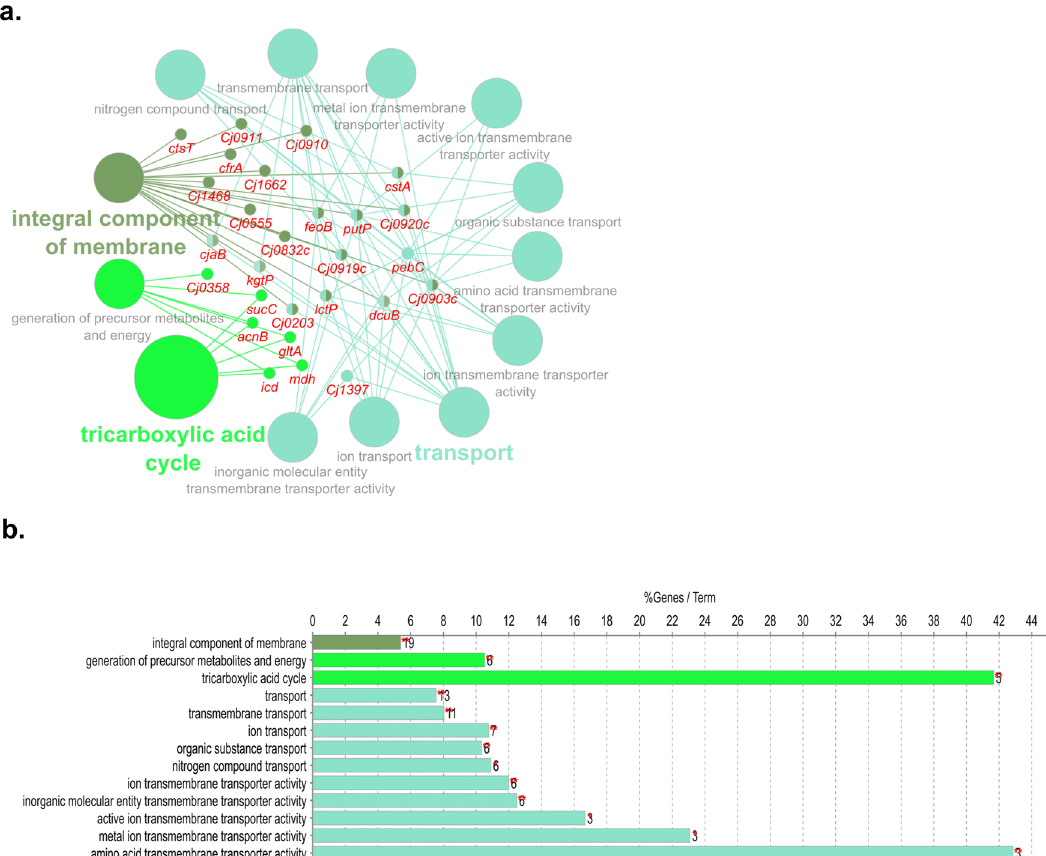
Fig. 6 Biological pathway analysis of DEGs in exposure to ASC vs. chlorine at 25 °C. Pathways enriched by mapping upregulated ( a , b ) DEGs obtained from C. jejuni post-exposure to ASC at 25 °C. DEGs signi fi cantly (FDR < 0.05; log 2 fold change >1 or < − 1) upregulated in C. jejuni were mapped in ClueGO and CluePedia plugins in Cytoscape and only signi fi cantly ( P < 0.05) enriched biological pathways were visualized. In the graph, the length of individual bars indicates the percent of DEGs associated with respective terms out of the total associated genes.